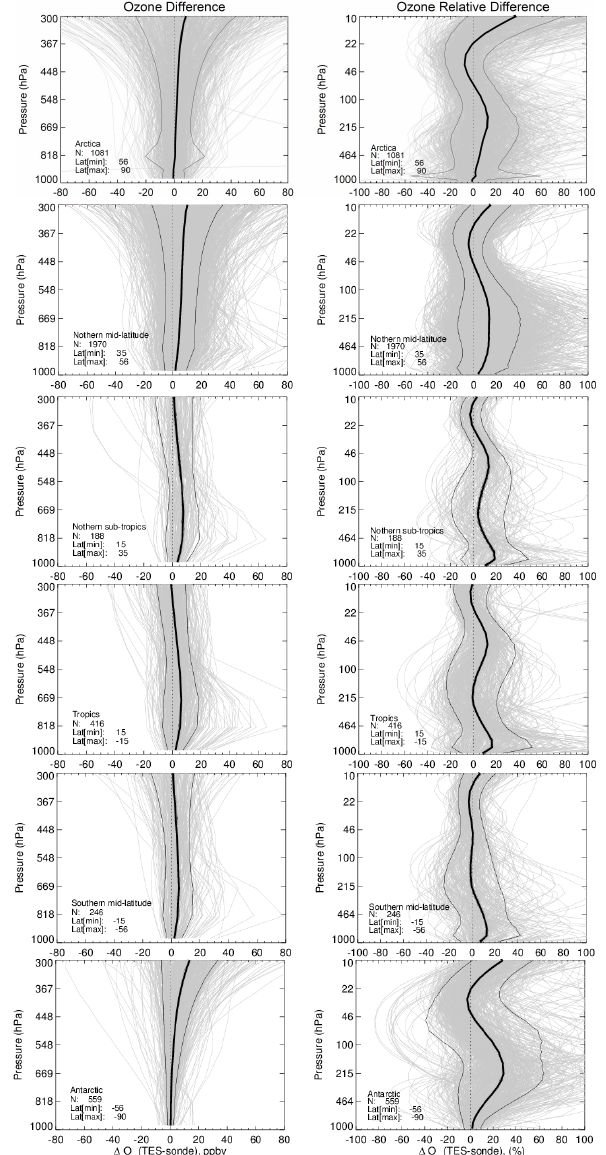
Fig. 4. Absolute TES–sonde O 3 differences (left panels) and rela- tive differences (right panels) for six latitude zones. Individual dif- ference profiles are shown in grey; the mean difference and 1 stan- dard deviation profiles are overlaid in black. N is the number of valid profiles after flagging TES data.